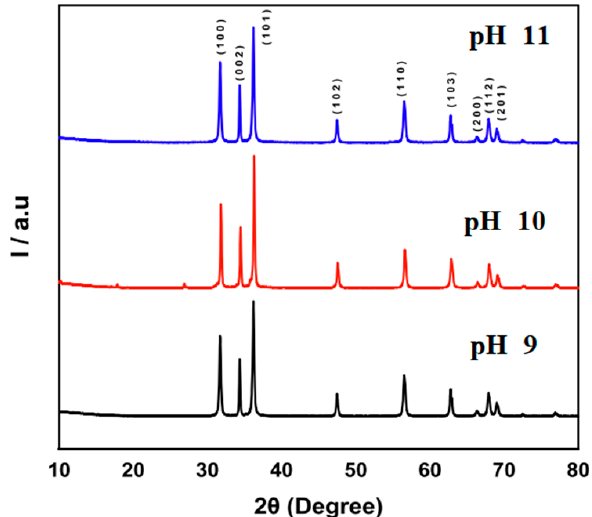
Figure 1. XRD patterns of ZnO with pH 9 (black), pH 10 (red) and pH 11 (blue). Figure 1. XRD pa tt erns of ZnO with pH 9 (black), pH 10 (red) and pH 11 (blue).